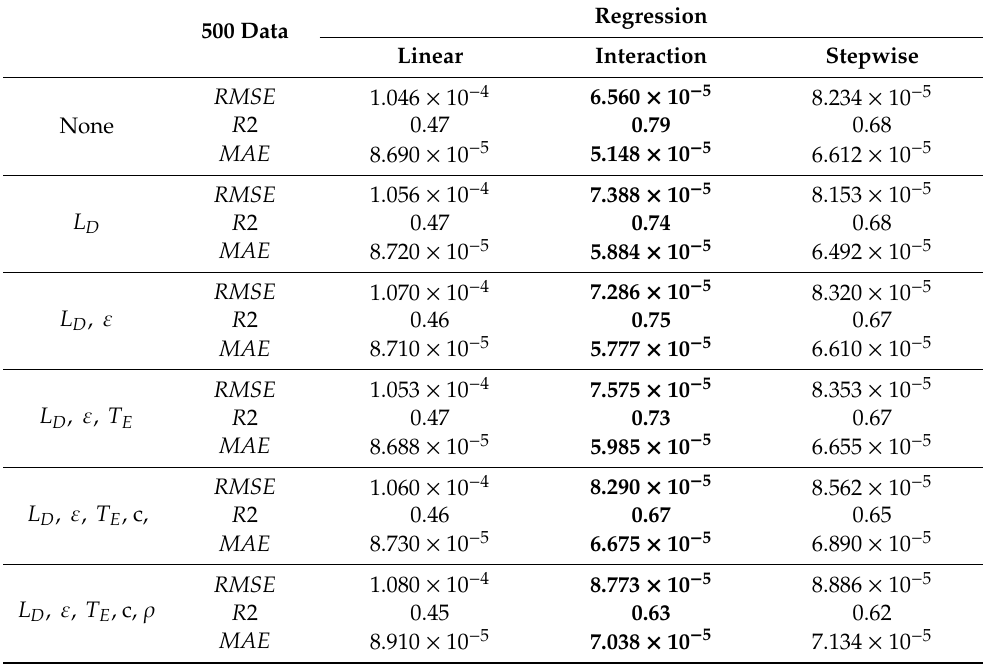
Table 2. Performance results for defect thickness predictor models using a dataset of 500 sets of values. The models with the best predictive performance are indicated in bold